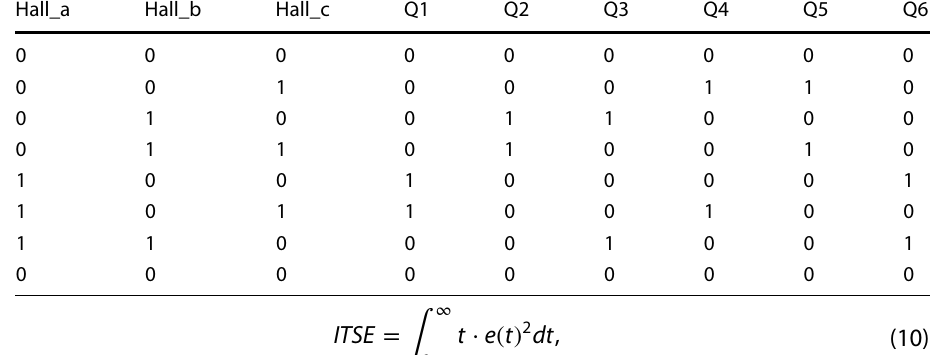
Table 4 Logical relationship between switching tube state and Hall signal